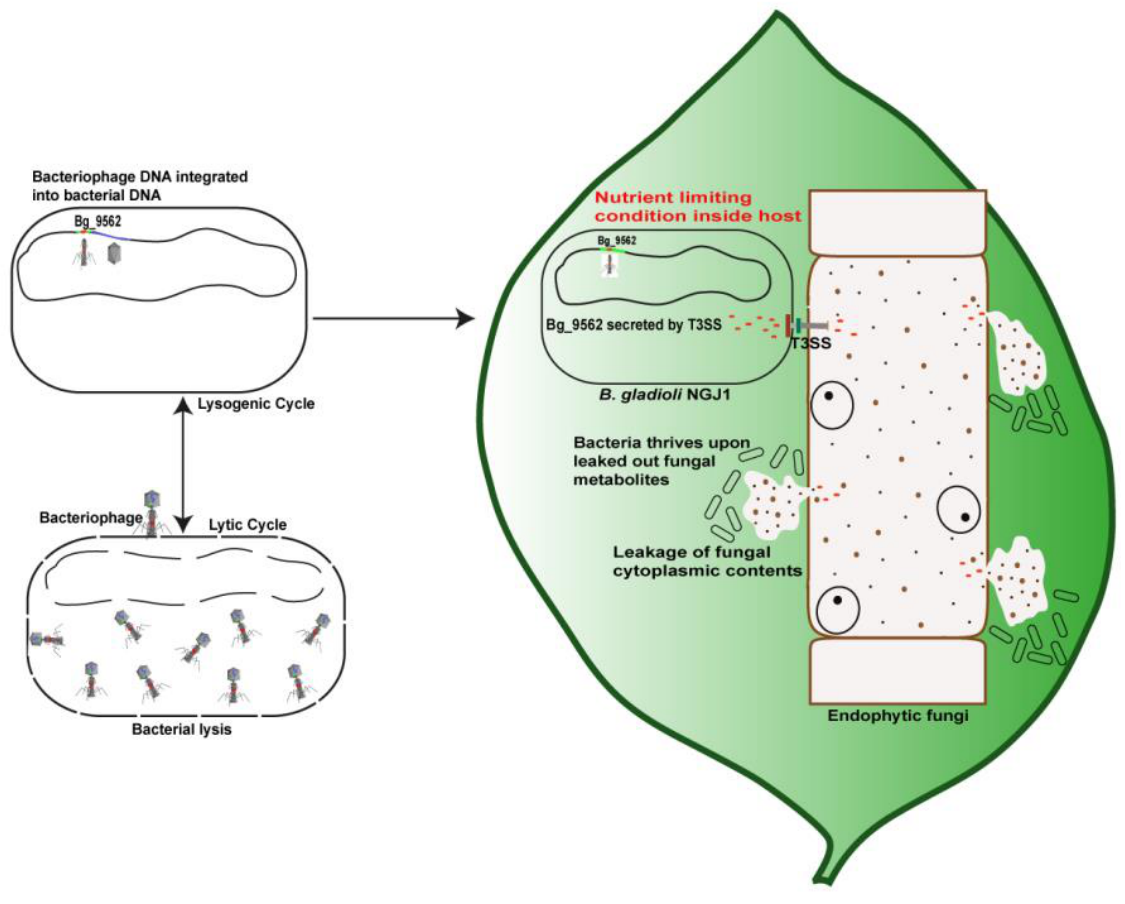
FIGURE 1: The mycophagous ability of NGJ1 would be advantageous for the bacterium to survive in a hostile environment. Bacterial genome contains bacteriophage clusters, which upon induction form phage particles and kill bacteria. However the B. gladioli strain NGJ1 had evolved to delete the head assembly proteins from the prophage cluster so that the phage particle cannot be induced. In this process, the bacterium seems to have evolved a T3SS signal in a prophage tail-like protein (Bg_9562) and delivers the protein into fungal cells in a functional T3SS dependent manner. By unknown mechanism, this induces fungal cell death responses and leads to disintegration of fungal hypha. This causes release of fungal cytoplasmic grannules as well as metabolites which the bacterium can utilize to sustain its growth. The mycophagous property of the bac- terium can help it to survive under nutrient limiting condition. Considering this, we speculate the NGJ1 to be a hub bacterium which can reshape the entire plant associated microbiome and however this needs to be experimentally